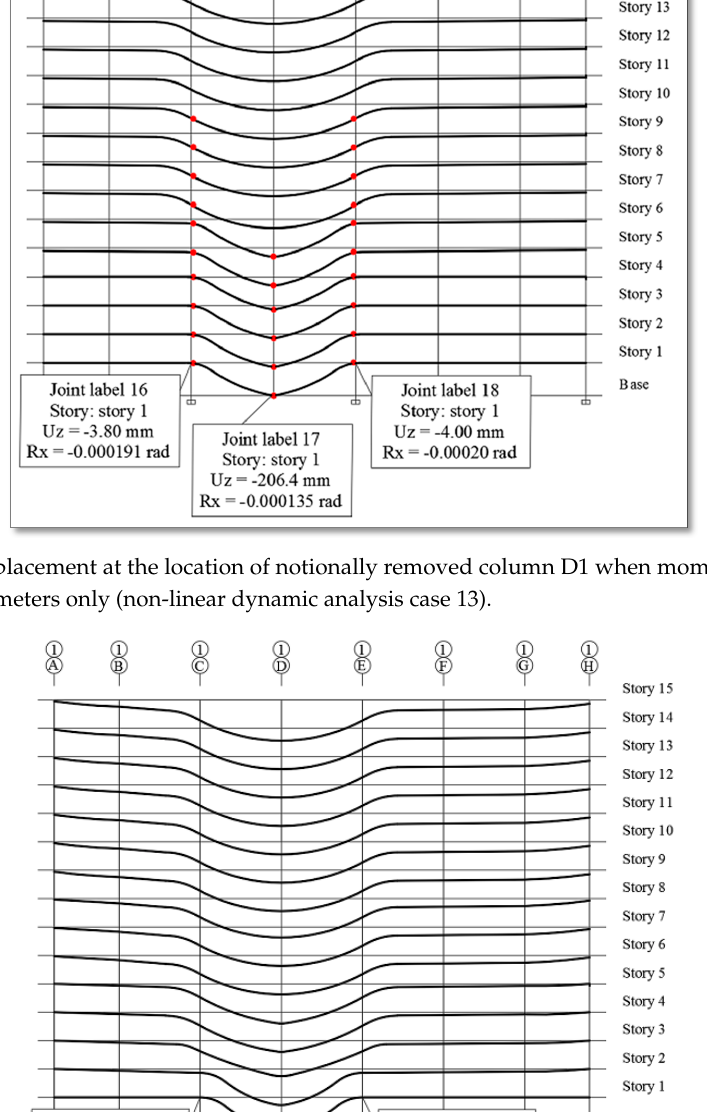
16 of 19 Table 10. Comparison between displacements and rotations when edge column D1 is removed. Case